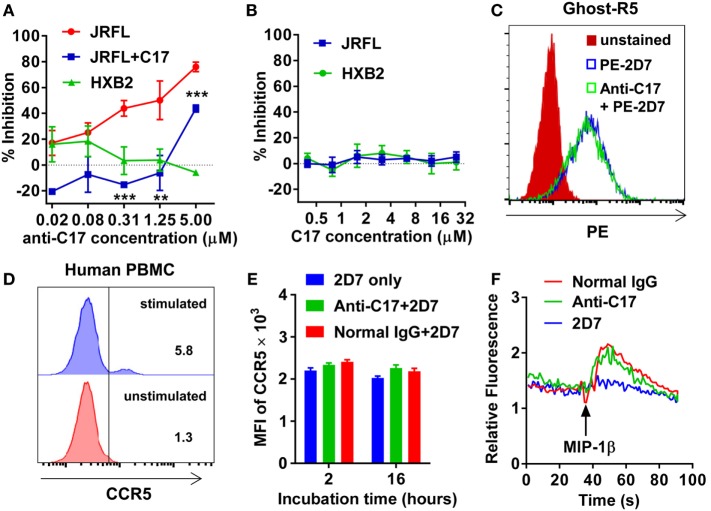
Membrane-proximal region (MPR)-specific antibodies inhibit HIV-1 infection. (A) Ghost-R5 or Ghost-X4 cells were incubated with fourfold serially diluted anti-C17, followed by infection of JRFL or HXB2 pseudovirus, respectively. Anti-C17 was preincubated with 25 µM C17 peptide to neutralize MPR-specific antibodies, and tested for the inhibition of JRFL pseudovirus (JRFL-C17). n = 3. An unpaired t-test was performed to show the difference between JRFL and JRFL-C17 at each concentration. (B) Ghost cells were incubated with twofold serially diluted C17 peptide, followed by infection of JRFL or HXB2 pseudovirus. n = 3. (C) Ghost-R5 cells were preincubated with anti-C17 at 37°C for 2 h. The C–C chemokine receptor type 5 (CCR5) on the cell surface was stained by PE-conjugated 2D7 antibody, followed by flow cytometry analysis. (D) Human peripheral blood mononuclear cells (PBMCs) were activated by PMA and ionomycin. CCR5+ cells were stained by 2D7 and gated. (E) Activated PBMCs were incubated with anti-C17 for 2 or 16 h, and mean fluorescence intensity (MFI) of 2D7-labeled CCR5 on CCR5+ cells was summarized. n = 3. (F) 293T cells expressing CCR5 were first incubated with antibodies, followed by stimulation with MIP-1β. The calcium flux indicated by fluorescence ratio of Fluo-4/FuraRed was recorded by flow cytometry. Data are presented as mean ± SEM. All experiments were repeated twice with similar results (**p < 0.01; ***p < 0.001).